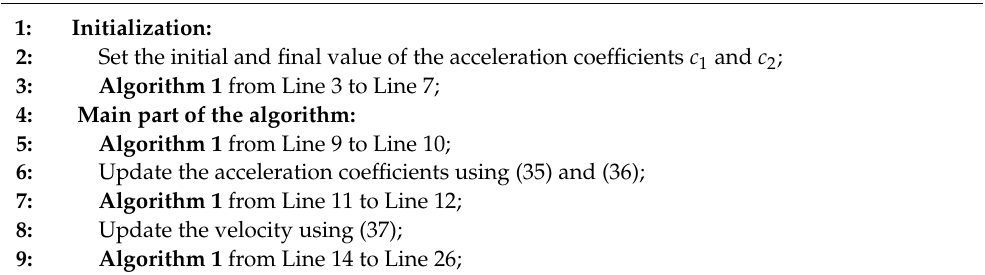
Algorithm 2 PSO-TVAC Algorithm for Optimization Problem